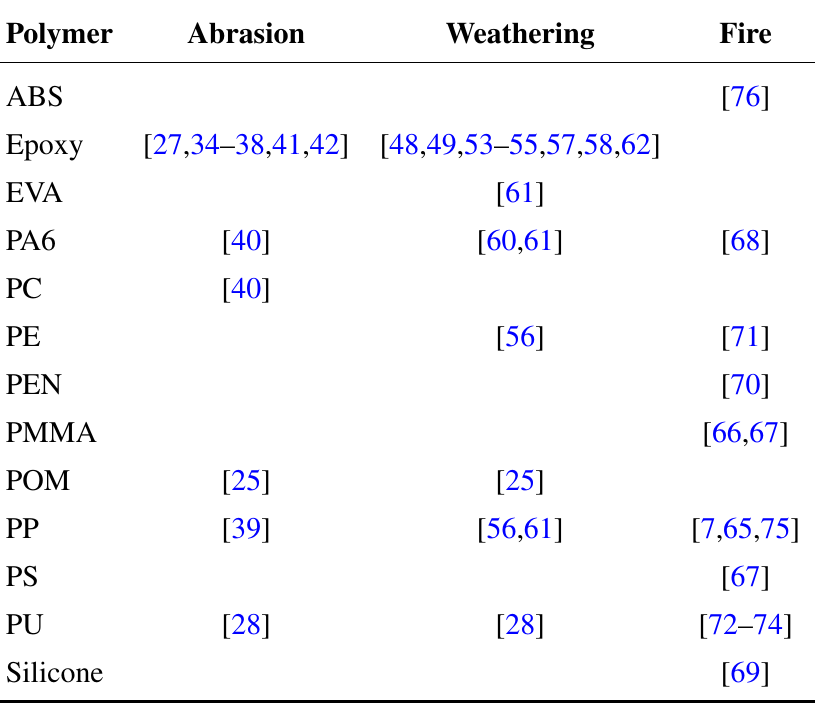
Table 5. Release studies for all investigated